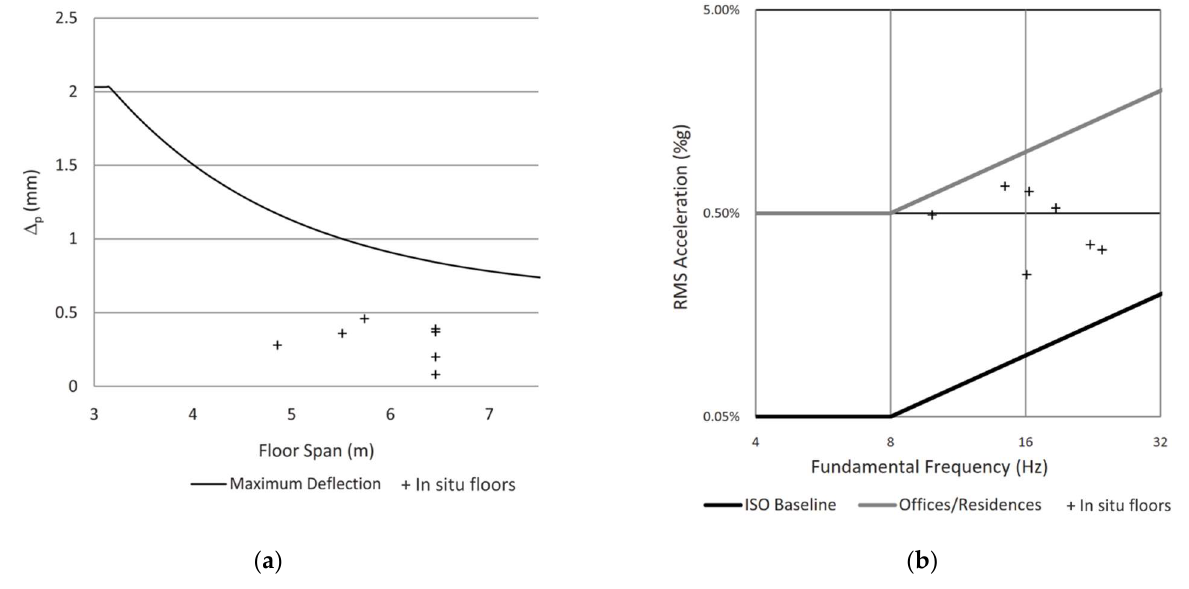
Figure 4. Investigation of floor vibration for in situ floors tested by Parnell et al. [35] according to ( a ) ATC [19] and ( b ) ISO [28]. Reproduced from [35] with permission.